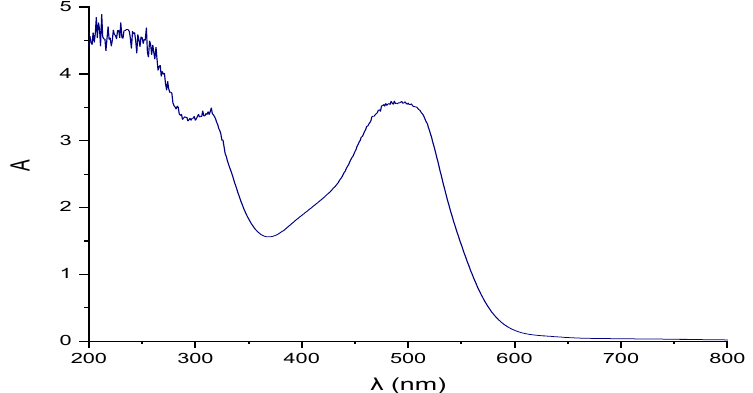
Figure 1. Industrial effluent coloration and Uv-vis spectra (200–800 nm). Uv-vis spectra confirmed the predominance of red coloration in the effluent, displaying a maximum band at 490 nm with high absorbance (A = 3.5 at 10% of effluent dilution). The strong coloration was associated with the content of red colorants in the mixture, such as red No. 2 (540 nm), red No. 3 (530 nm), and red No. 40 (520 nm). In addition, a small band at 430 nm was observed, indicating the presence of yellow dyes, such as yellow No. 5 (430 nm), which explains the shift to the left of the band of red dyes. Spectra also showed bands in the UV range at 320 nm, indicating the presence of azo groups. In turn, bands at 200–300 nm may indicate aromatic groups and salt content in the effluent.The presence of these colorants in the effluent was confirmed by scanning synthetic water containing a single component, a mixture of these colorants, and salt. Maximum absorbances for single components were as follows: red 40 (520 nm), red 2 (504 nm), and yellow 5 (390 nm). The maximum wavelength of the mixture of synthetic dyes and salt indicated a maximum band at 500 nm. The differences in spectra of the industrial effluent and the synthetic wastewater were attributed to the presence of salt, which caused shifts to the right and left, according to the spectrum of each colorant. This fact was associated with the aggregation of the dye or dyes with the salts present in the effluent.